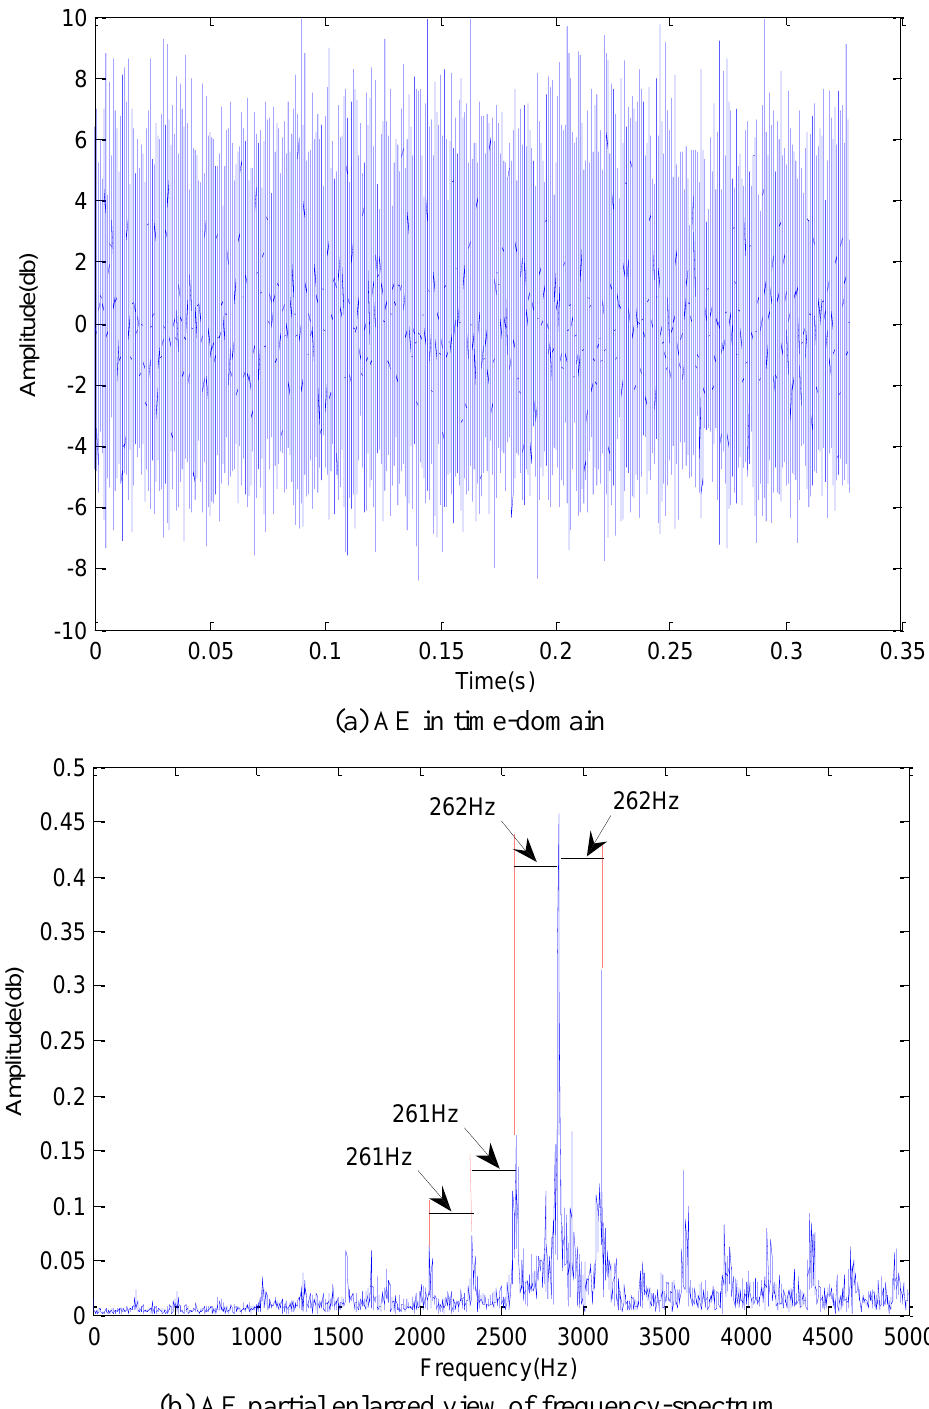
Figure 7. AE signals in time-domain and